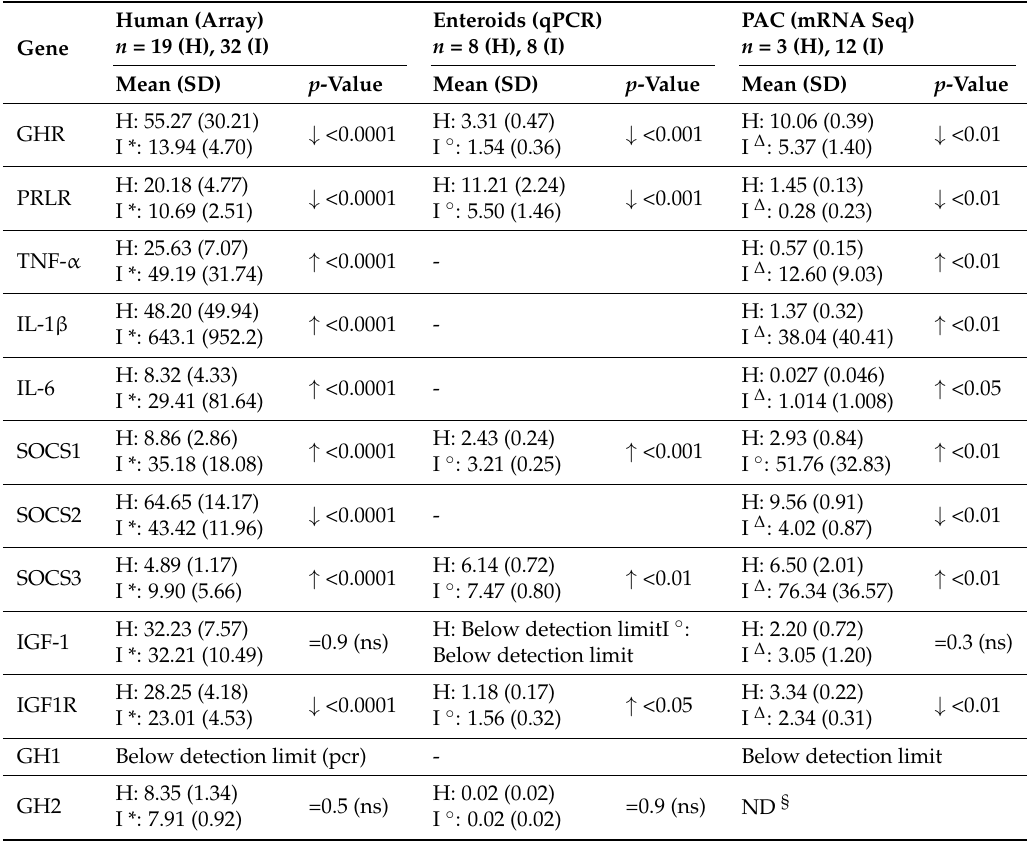
Table 2. Comparison of transcripts across model